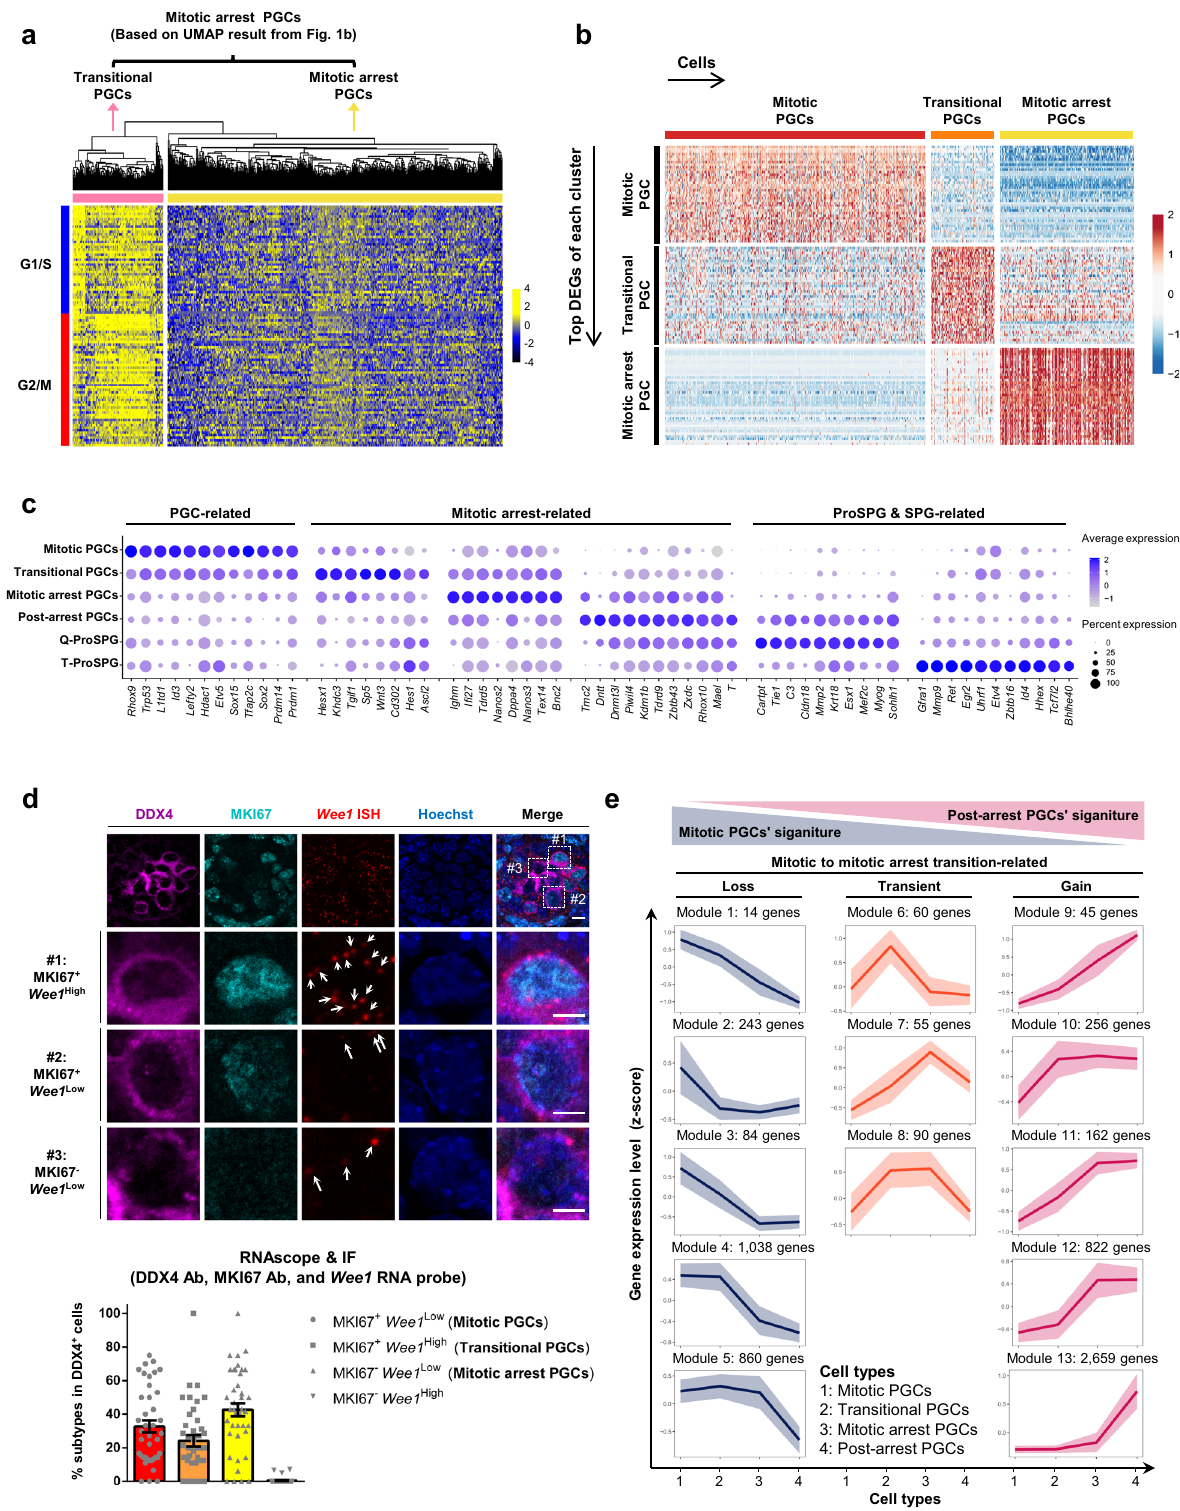
factors speci fi c for the transitional PGCs (Supplementary Fig. 4i, Supplementary Data